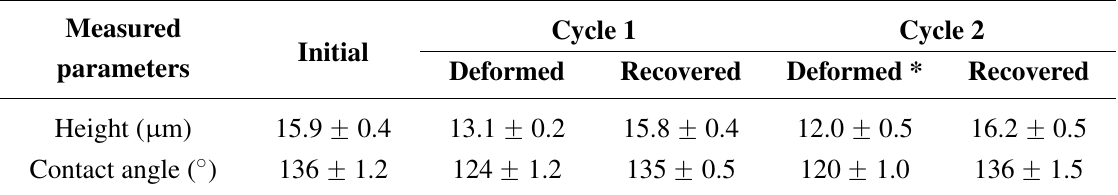
Figure 4. Water contact angle on unstructured crosslinked polycyclooctene (PCO) surface. Table 2. Height of the micropillars and contact angle on the surface of the PCO+2%DCP sample at the different steps in the shape memory process, Cycle 1 and Cycle 2.